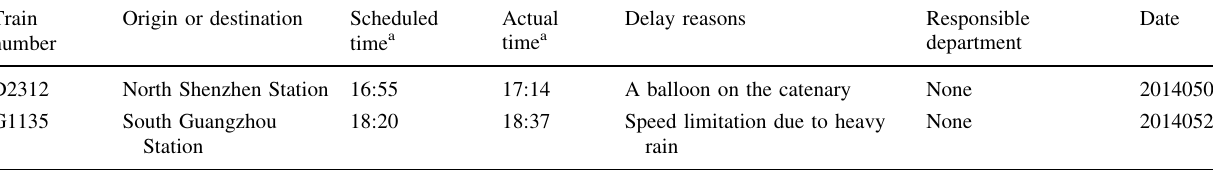
Table 1 Format of the original data sample Train Origin or number